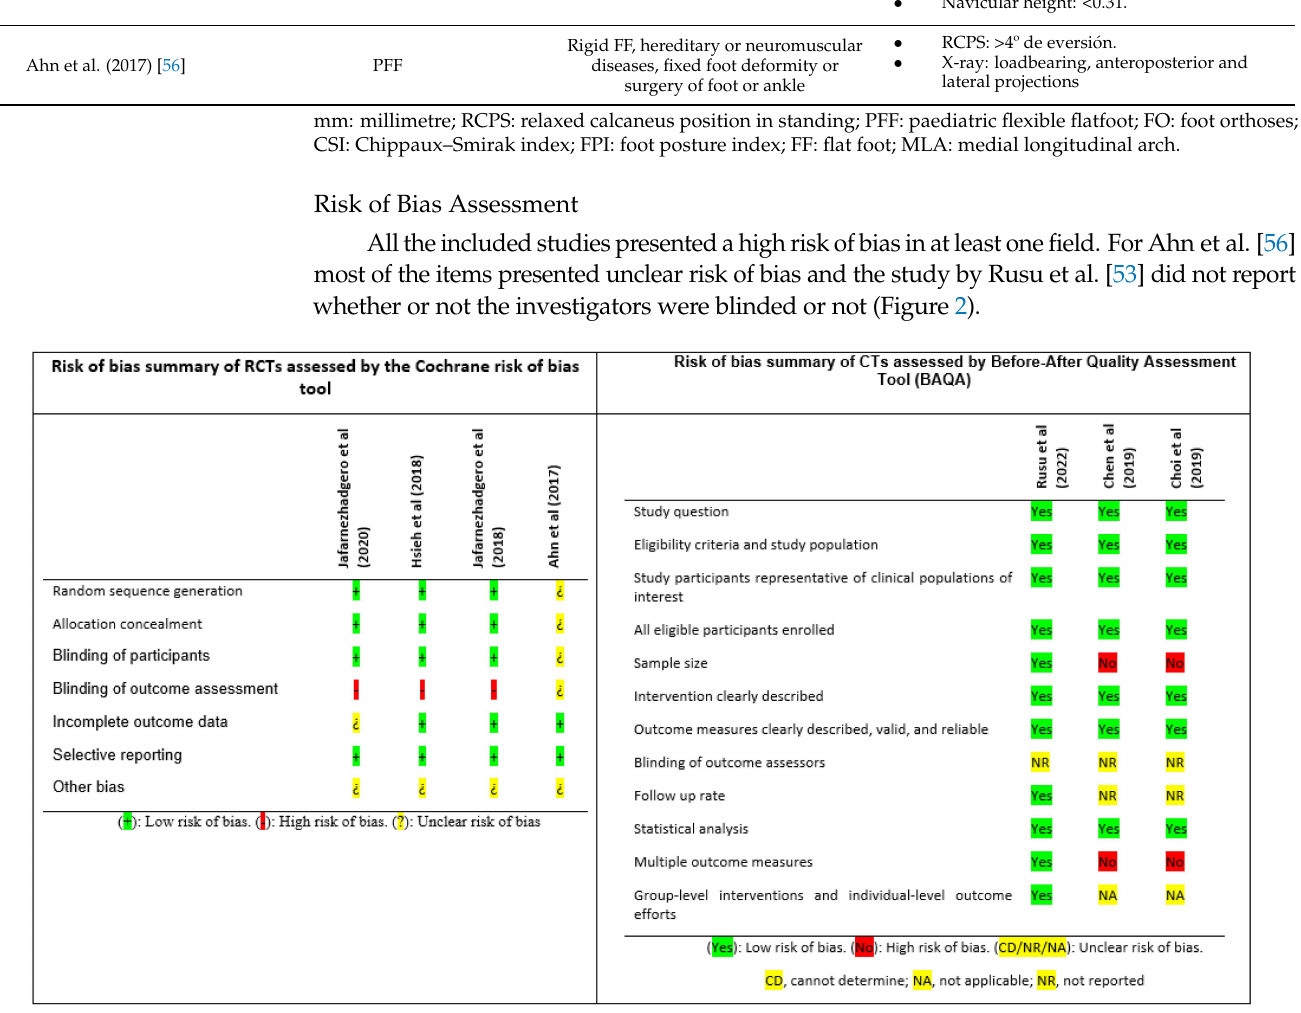
Figure 2. Risk of bias of the included studies. RCT: randomised controlled trial; CCT: